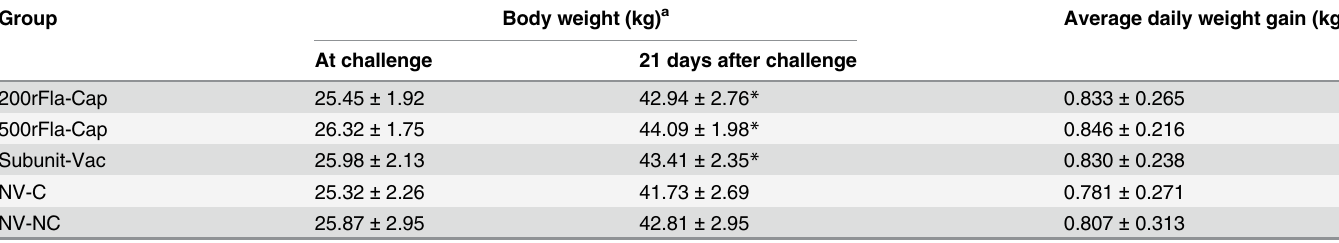
Table 1. Average body weights of rFla-Cap vaccinated pigs following PCV2 challenge.